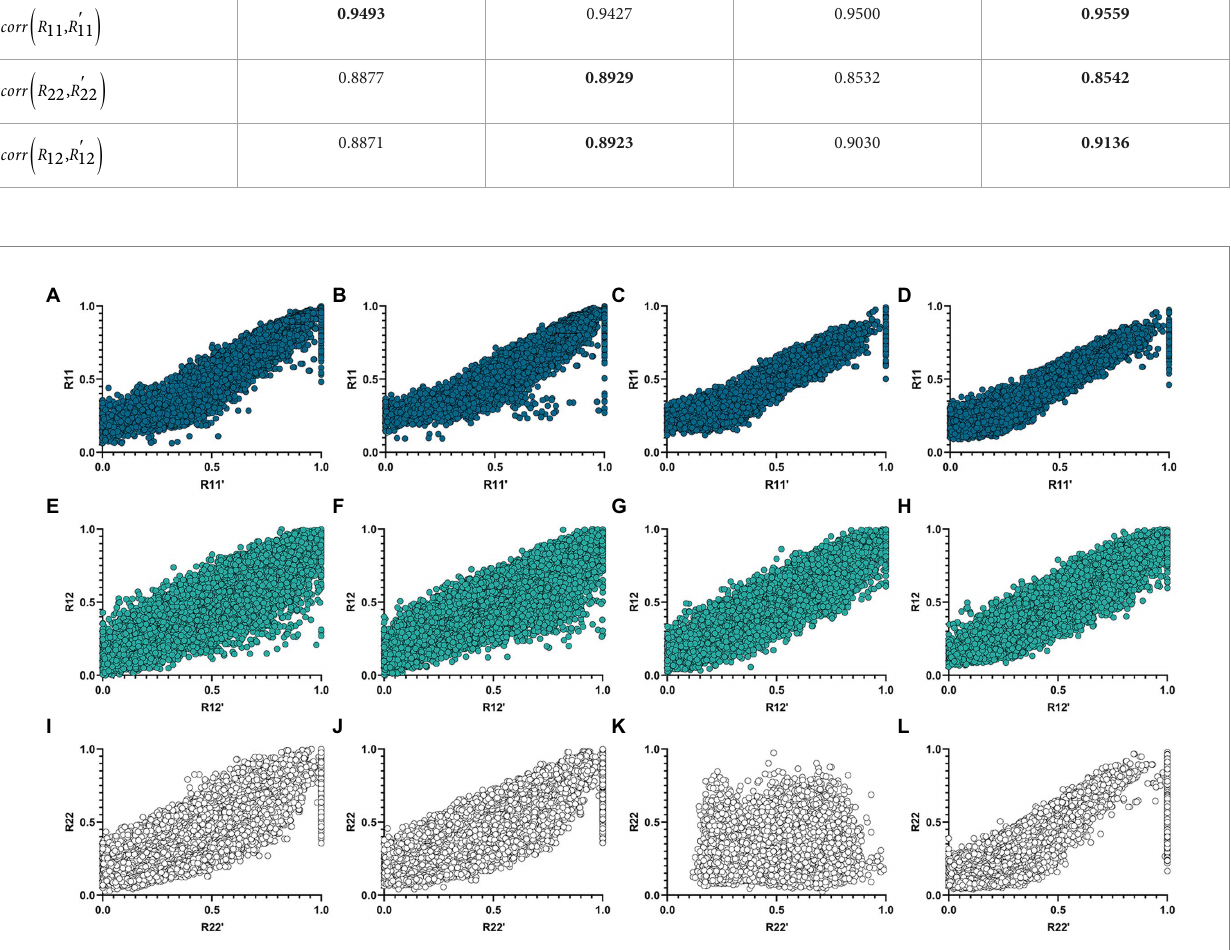
FIGURE 3 Correlation scatter plots of 11 R , 12 R , and 22 R of the two algorithms and their reconstruction matrices 11 R ′ , 12 R ′ , and 22 R ′ in the AD and MCI groups. (A,E,I) Are three sets of scatter plots obtained by the netNMF algorithm in the AD group. (B,F,J) Are three groups of scatter plots obtained by the HG-netNMF algorithm in the AD group. (C,G,K) Are three sets of scatter plots obtained by the netNMF algorithm in the MCI group. (D,H,L) Are three groups of scatter plots obtained by the HG-netNMF algorithm in the MCI